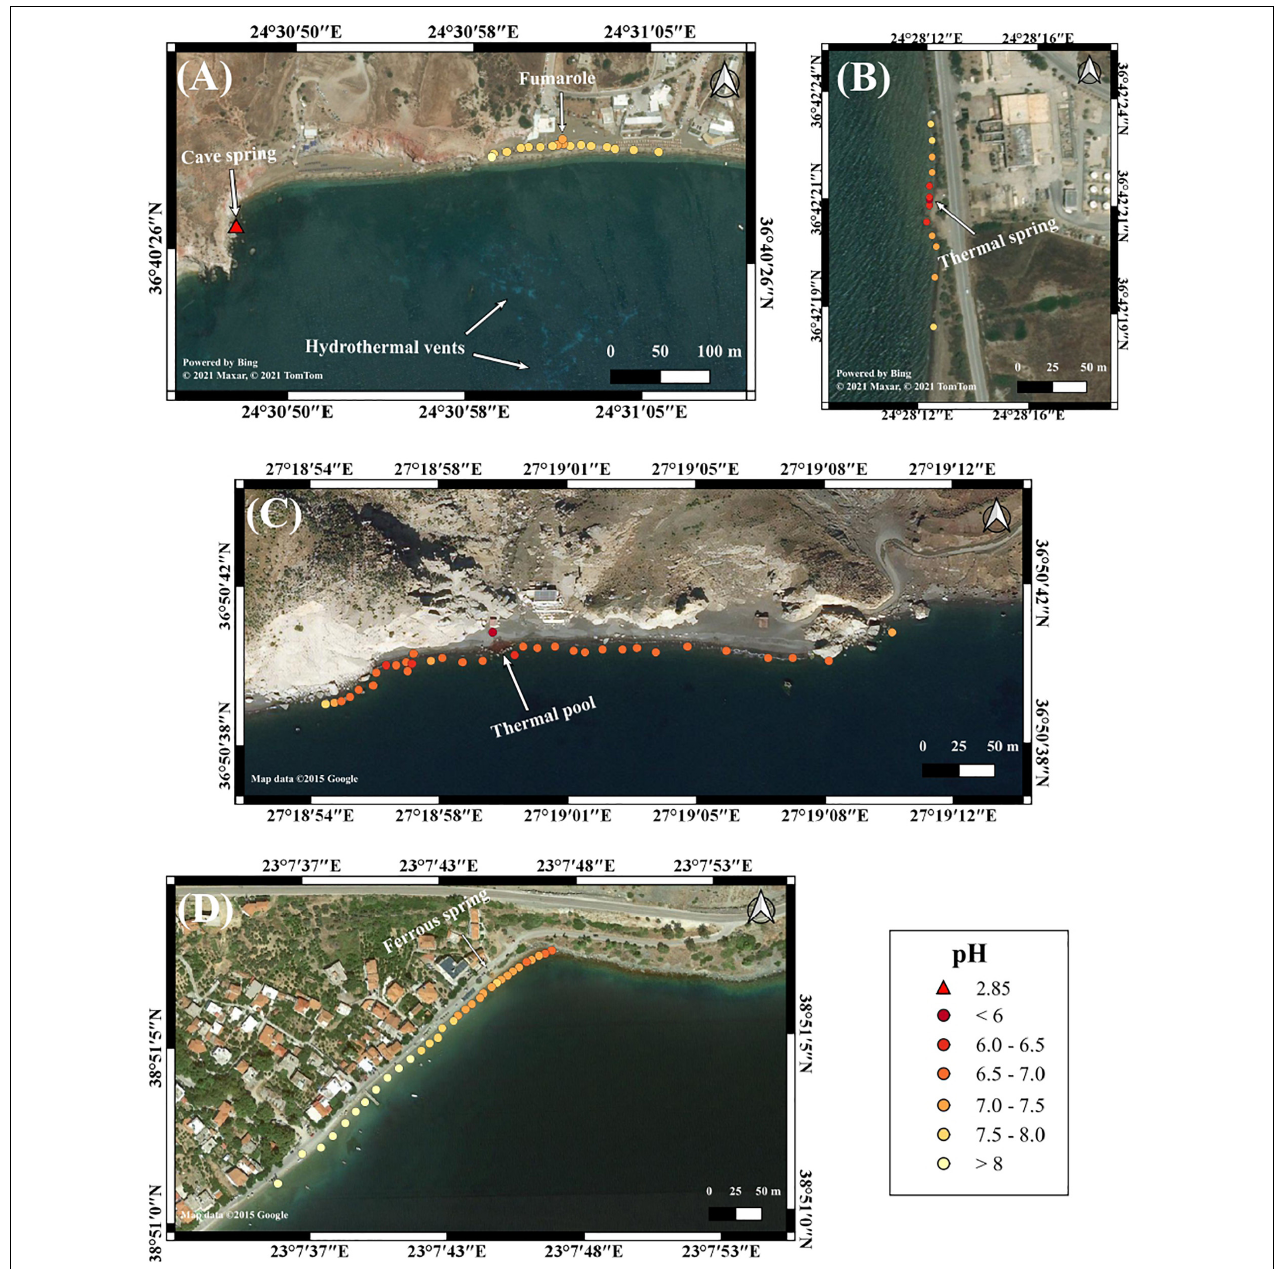
FIGURE 11 | pH transects for the areas of (A) Paleochori and (B) Kanavas at Milos, (C) Therma at Kos, and (D) Ilion at Euboea. Points of particular interest are marked with an arrow. The morphology of the seashore at Paleochori (A) was diverse when the measurements took place.